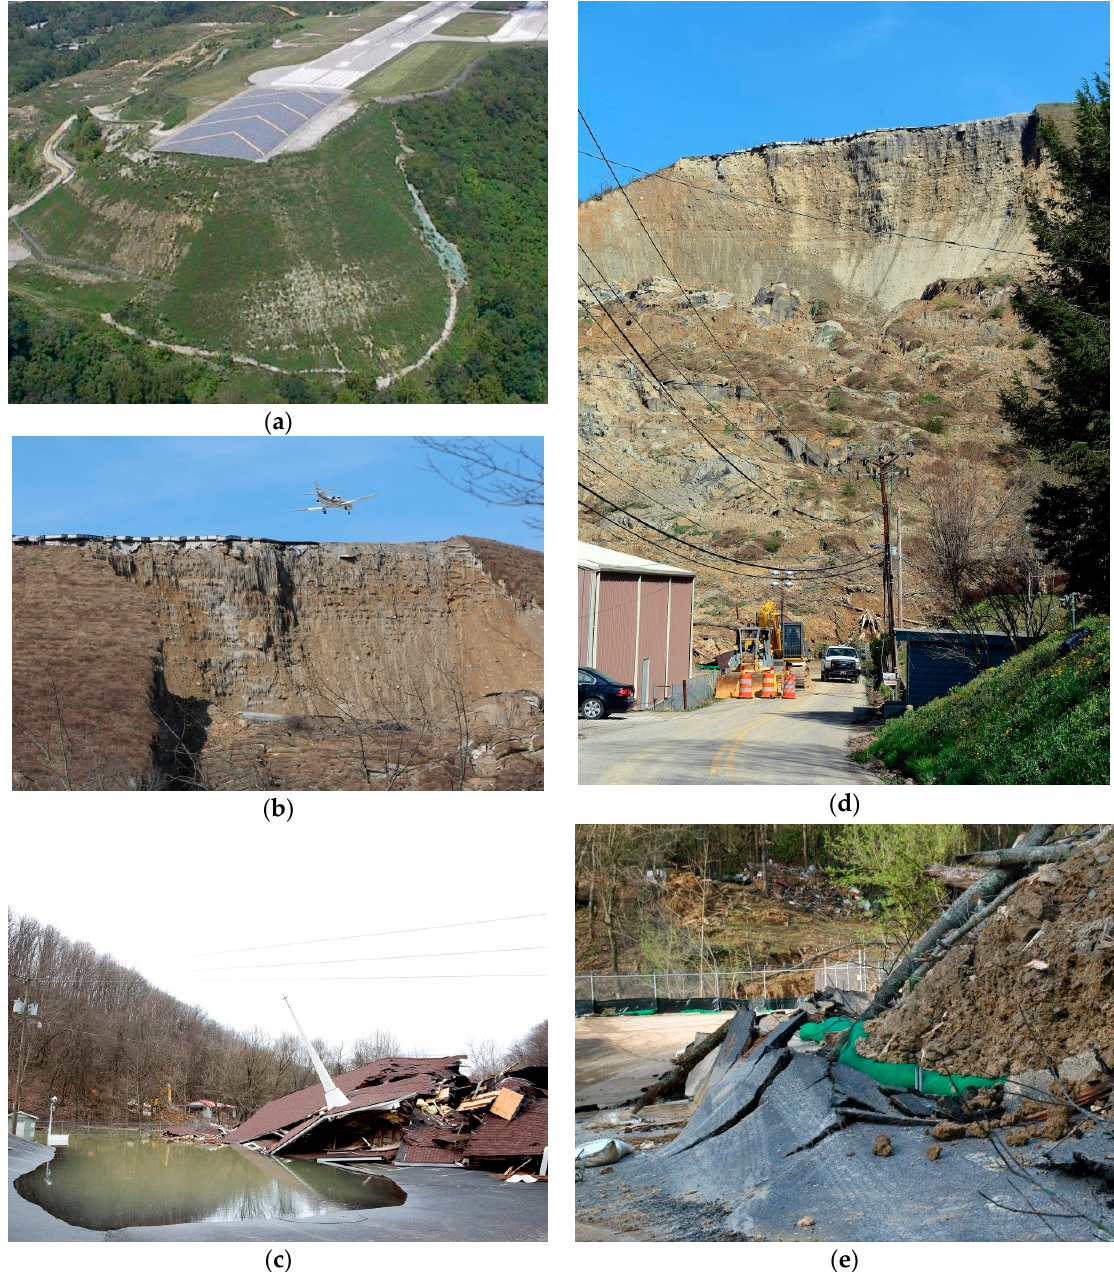
Figure 1. ( a ) Pre-failure photograph of the Yeager Airport [42]; ( b ) top of the landslide, showing the remains of the EMAS (white) and the geosynthetic reinforcements (Marcus Constantino, Charleston Gazette 12 March 2015 [44]); ( c ) the remains of the Keystone Apostolic Church, which was damaged by the landslide (Tyler Bell, Charleston Gazette 13 March 2015 [45]); ( d ) after the 2nd slope failure (F. Brian Ferguson, Charleston Gazette 13 April 2015 [46]); and ( e ) rolling up of asphalt at the toe of the landslide (Rusty Marks, Charleston Gazette 13 April 2015 [46]).